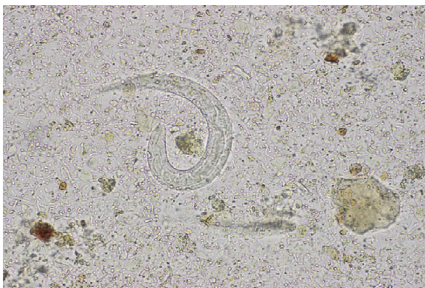
Figure 1: Wet mount of stool showing Strongyloides